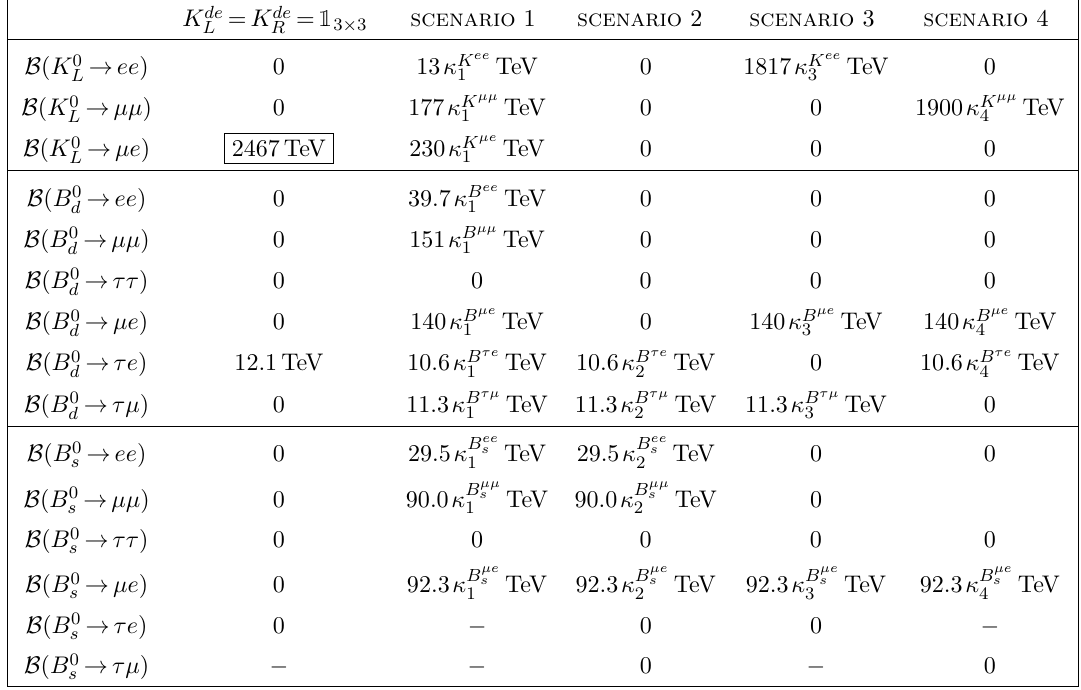
Table 3 . Limits on the gauge leptoquark mass m X compared to current measurements (or upper limits) for the mesons K 0 , B 0 and B 0 . Each column represents different choices for the matrices s L d where scenarios 1–4 are given by eqs. (3.3), (3.5), (3.7) and (3.9) respectively. Each scenario K de L/R corresponds to possible structures of the mixing matrices which would in some way suppress the decays of K 0 . In scenario 1 the decays to K 0 are non-zero albeit helicity-suppressed, leading to L L mass limits similar to what is obtained from decays of B 0 and B 0 . Scenario 2 completely suppresses s d the decays of K 0 and the most significant mass limits now come from the decays of B 0 . Scenario 3 s L and 4 correspond to examples of mixing matrices which would suppress the decay channel K 0 → µe L but not K 0 → ee or K 0 → µµ which would form the dominant limit. The first column represents a L L scenario which maximises the rate of K 0 → µe decays leading to the largest mass limit on X µ . In L all the scenarios above the parameter κ X corresponds to the combination of mixing angles relevant α to that decay chain. We find the lower bound on the PS breaking scale to be no smaller than O (100) TeV. For the final two channels B 0 → τe/τµ there are currently no measured upper bounds, s however non-zero contributions to these channels are indicated by ‘ − ’ and their future measurement will form a constraint for a given choice of K de L/R